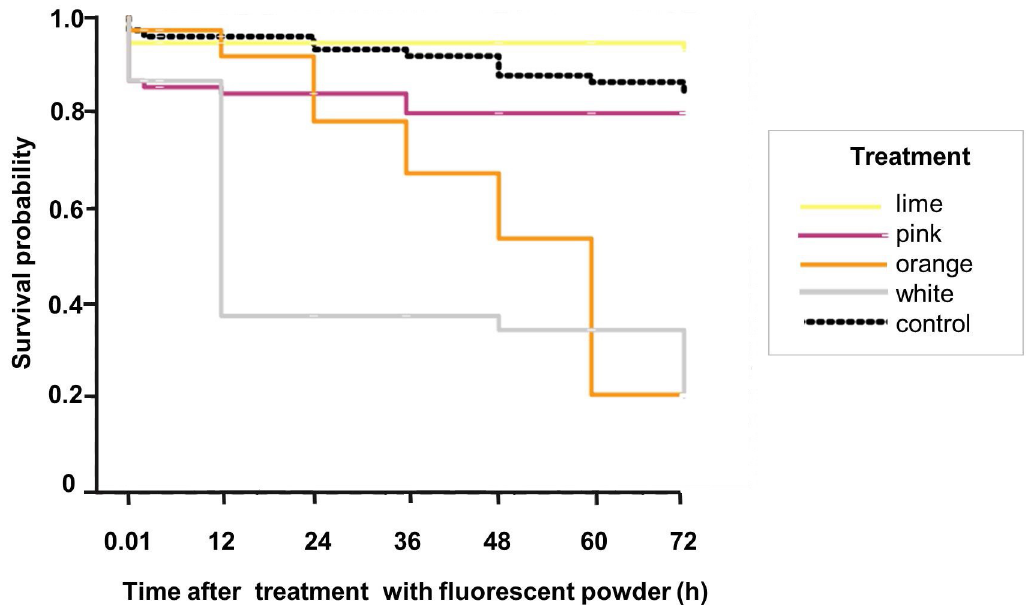
Fig 3. Kaplan-Meier survival curves for Lu . longipalpis . Sand flies were marked with one of four fluorescent powders (lime, pink, orange or white) and their survival over 72h in laboratory conditions was recorded. Control sand flies (black) were not marked with fluorescent powder but were similarly observed for